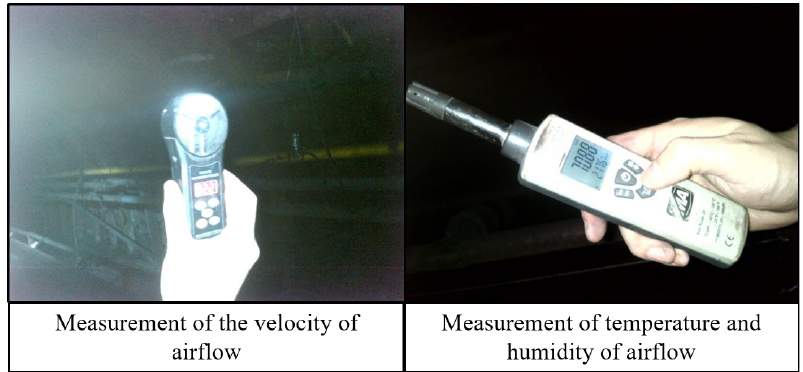
Figure 2. In situ determination of airflow thermodynamic parameters.